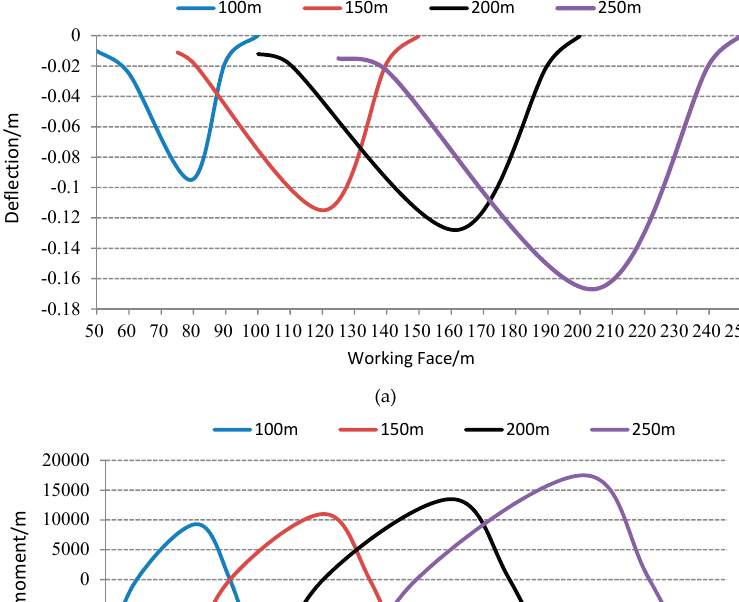
Figure 6. Roof deformation and internal force under different backfilling ratios: ( a ) Deflection; ( b ) bending moment; and ( c ) rotation.